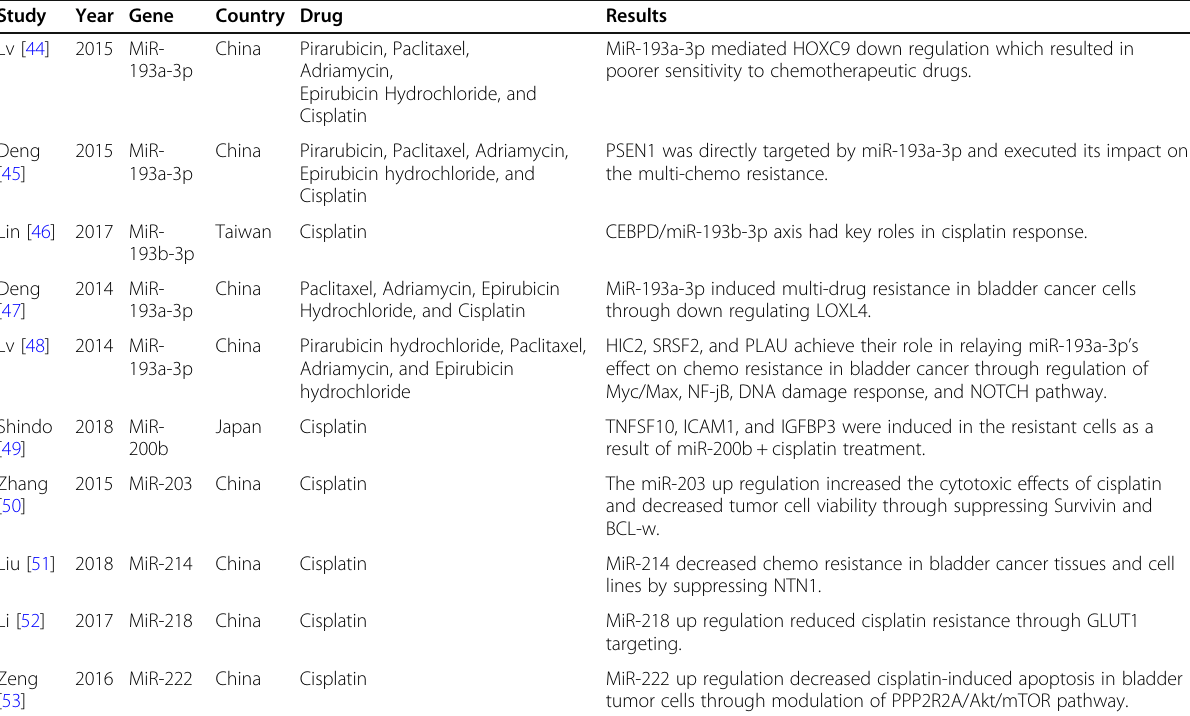
Table 1 all of the ncRNAs associated with chemotherapeutic resistance in BCa (Continued)